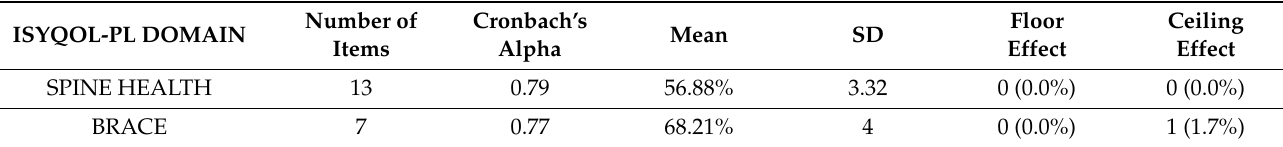
Table 3. Cronbach’s alpha, mean (%), and SD, floor and ceiling effects for each ISYQOL-PL domain. ISYQOL-PL